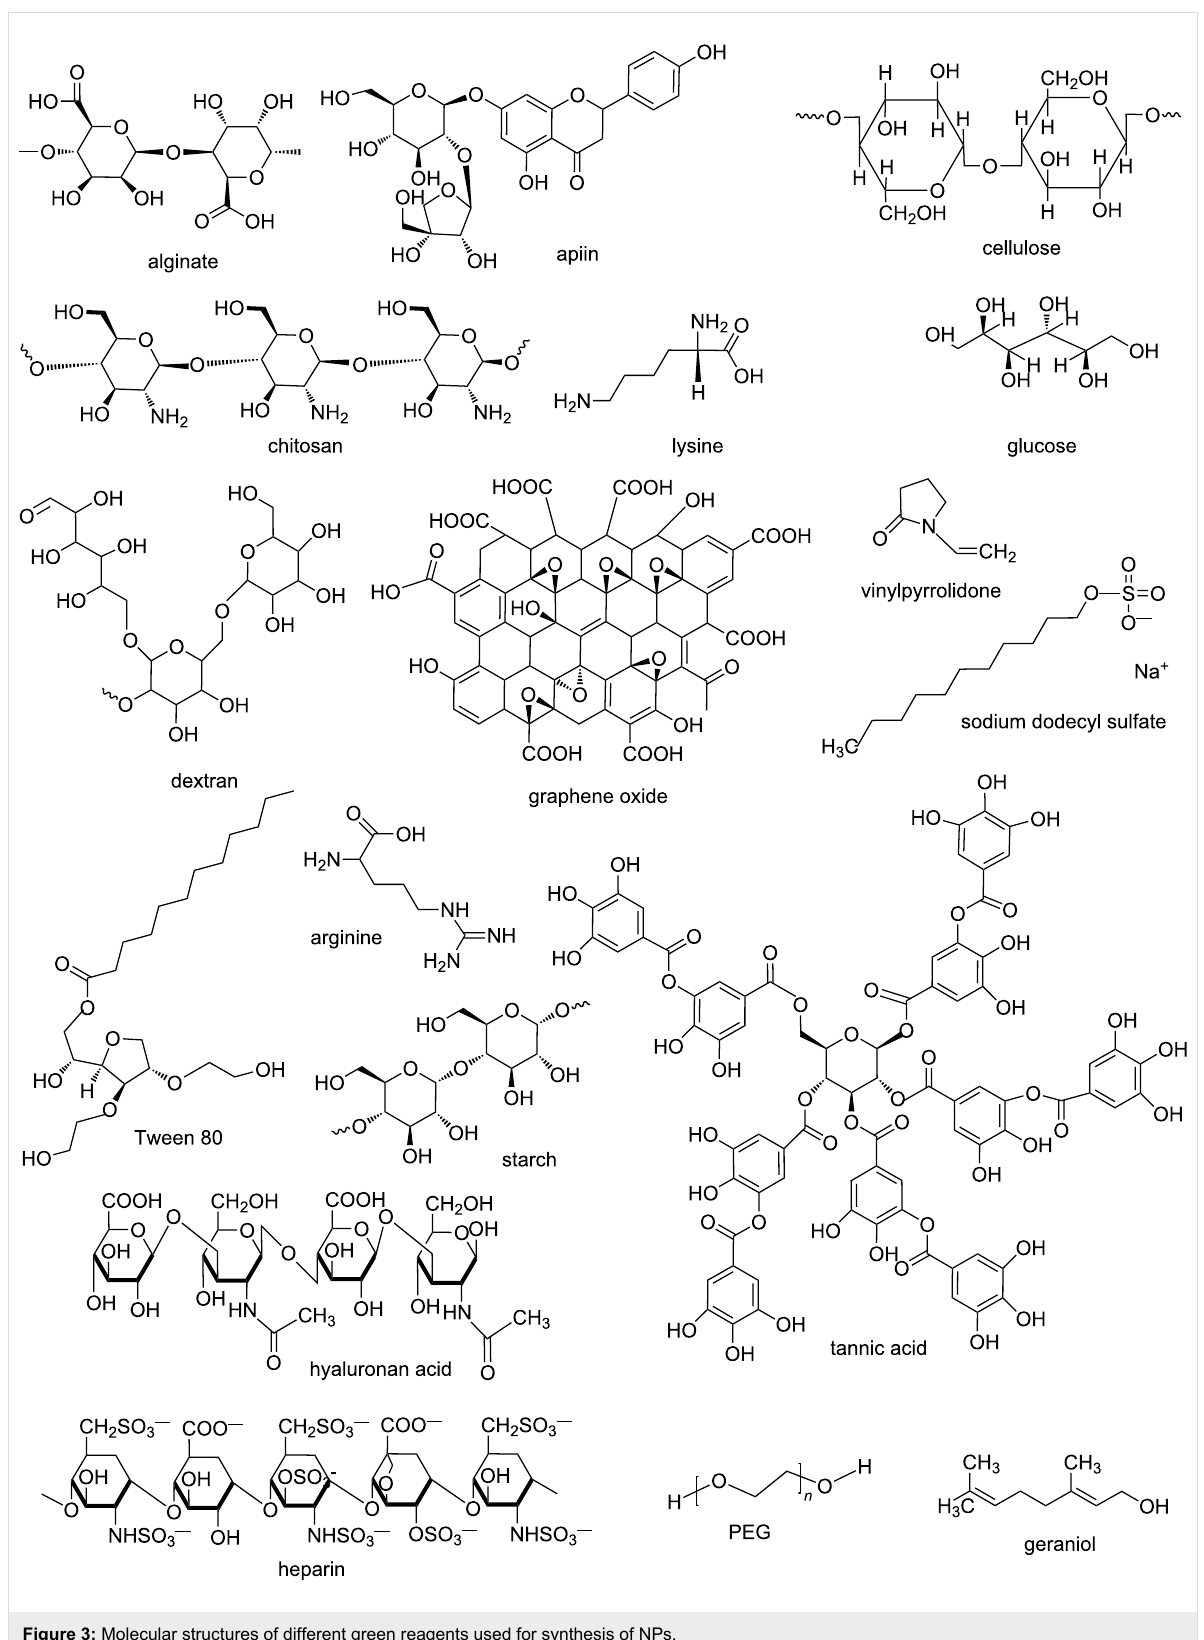
Figure 3: Molecular structures of different green reagents used for synthesis of